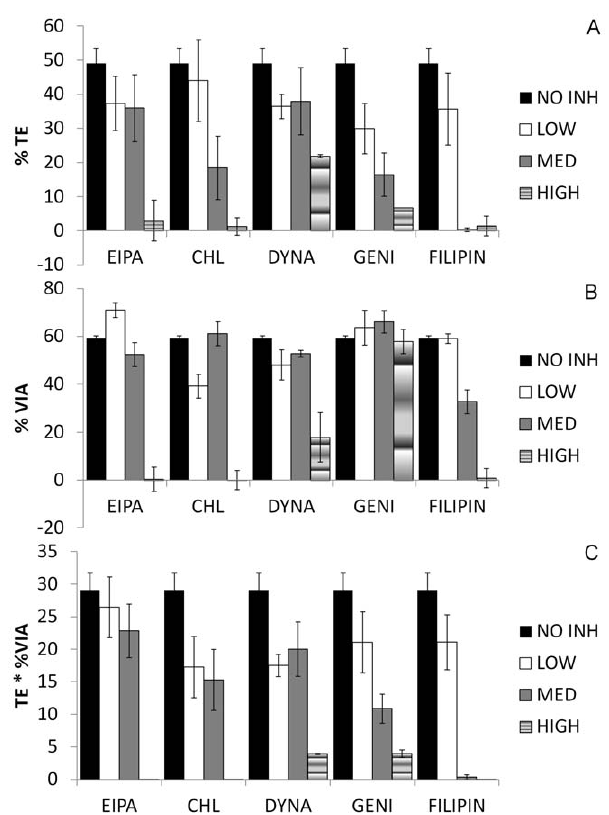
Figure 4. Effects of inhibitors on transfection and cell viability. HeLa cells were transfected with pEGFP-N1 in the presence of varying doses of inhibitors, as indicated and described in the Methods section. Transfection efficiency (A), viability (B) and Total Transfection (C) were determined 24 hr post-transfection using flow cytometry or MTT assay, respectively, and expressed as the mean 6 SD of at least three independent experiments.